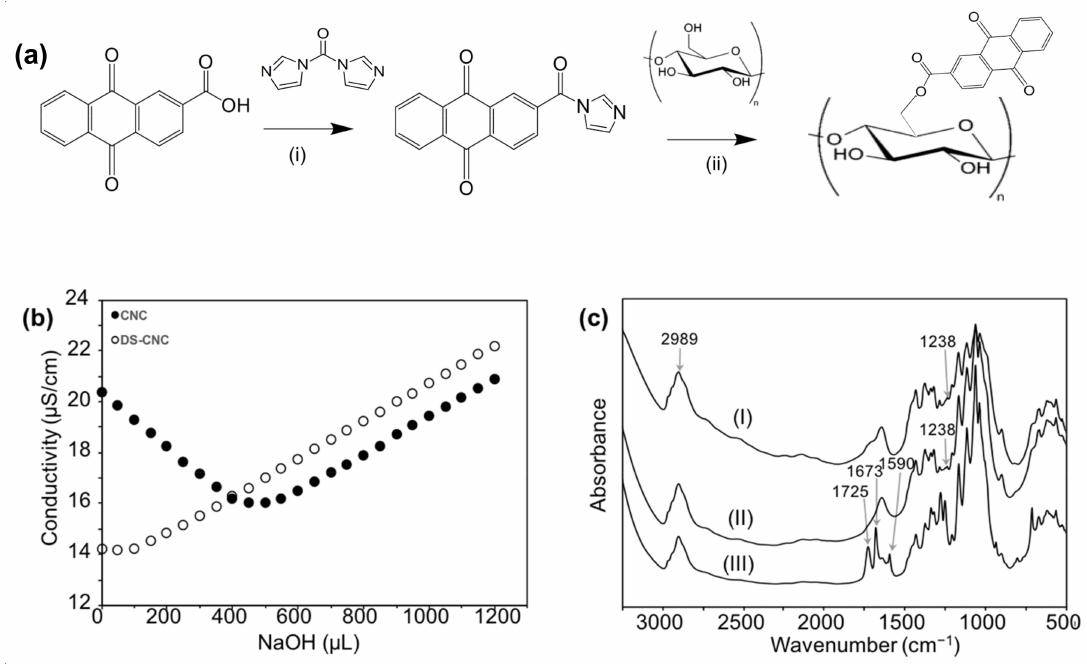
Figure 1. Preparation and characterization of the desulfated CNCs (DS-CNC) and AQ-CNCs. ( a ) Synthesis of AQ-CNCs: (i) DMF at 80 ◦ C for 0.5 h and (ii) DMF at 80 ◦ C for 2, 8, 12, and 24 h. ( b ) Conductometric titration curves of the CNC samples. ( c ) FTIR of the (I) CNCs, (II) DS-CNCs, and (III)